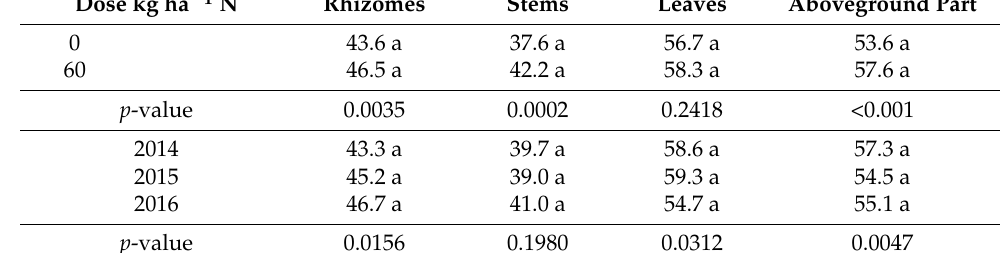
Table 1. Crude ash content in dry matter of miscanthus in g kg − 1 (average for the years 2014–2016).